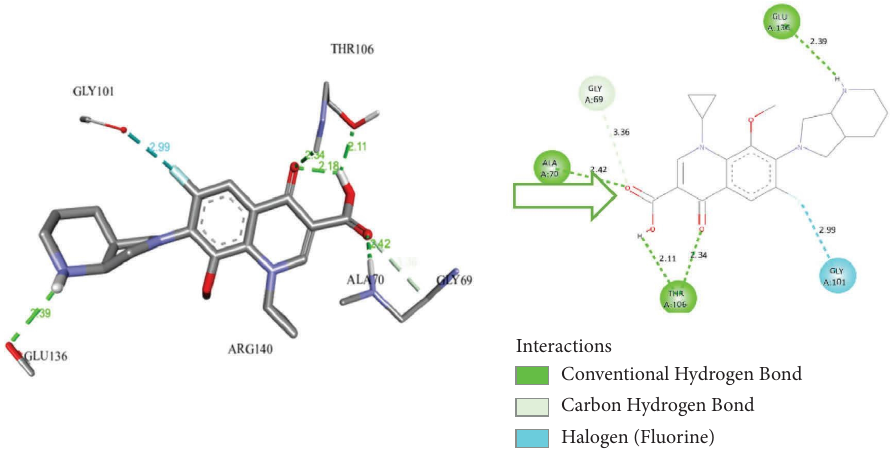
Figure 4: 3D & 2D interaction of reference Moxifoxacin A21 with FtsZ protein. Table 2: Biological activity of top 7